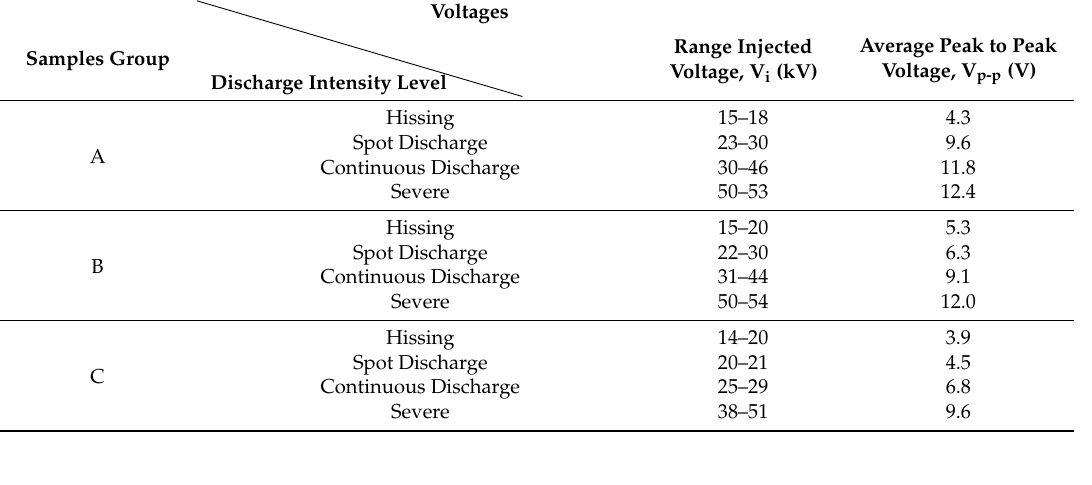
Table 8. Injected voltage and average peak-to-peak voltages of the UV signals for wet insulators conditions without contamination.